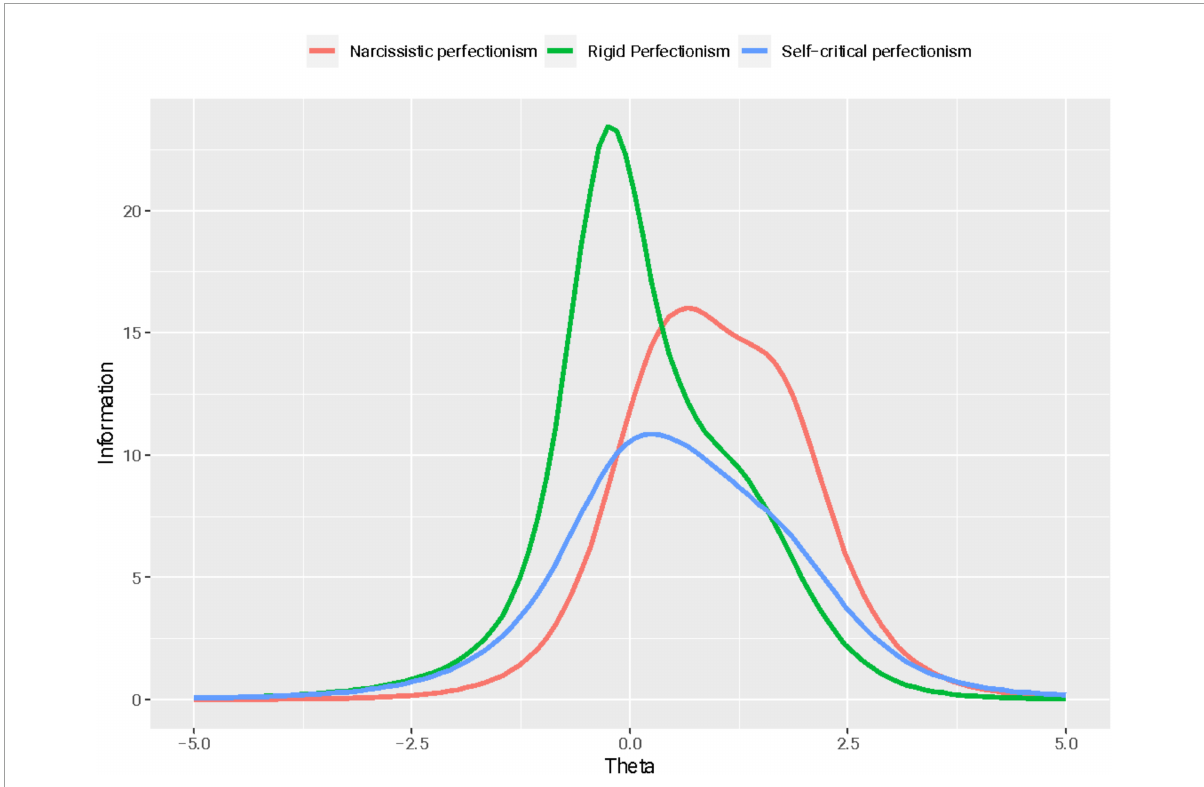
FIGURE2 The Big Three Perfectionism Scale–Short Form: Test information functions (GPCM Model) ( n = 401).